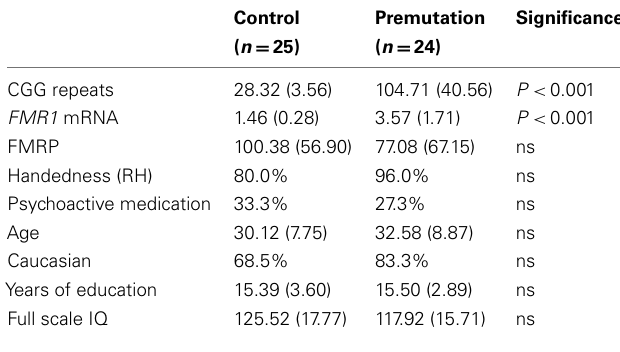
Table 1 | Molecular genetic, demographic, and clinical descriptive statistics by